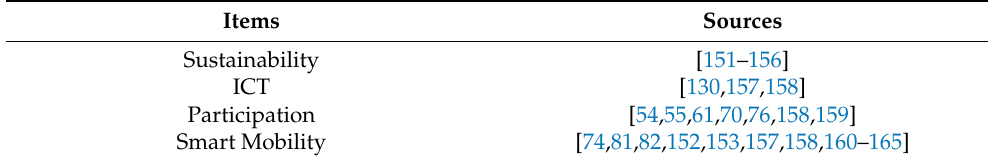
Table 2. Literature sources for items.